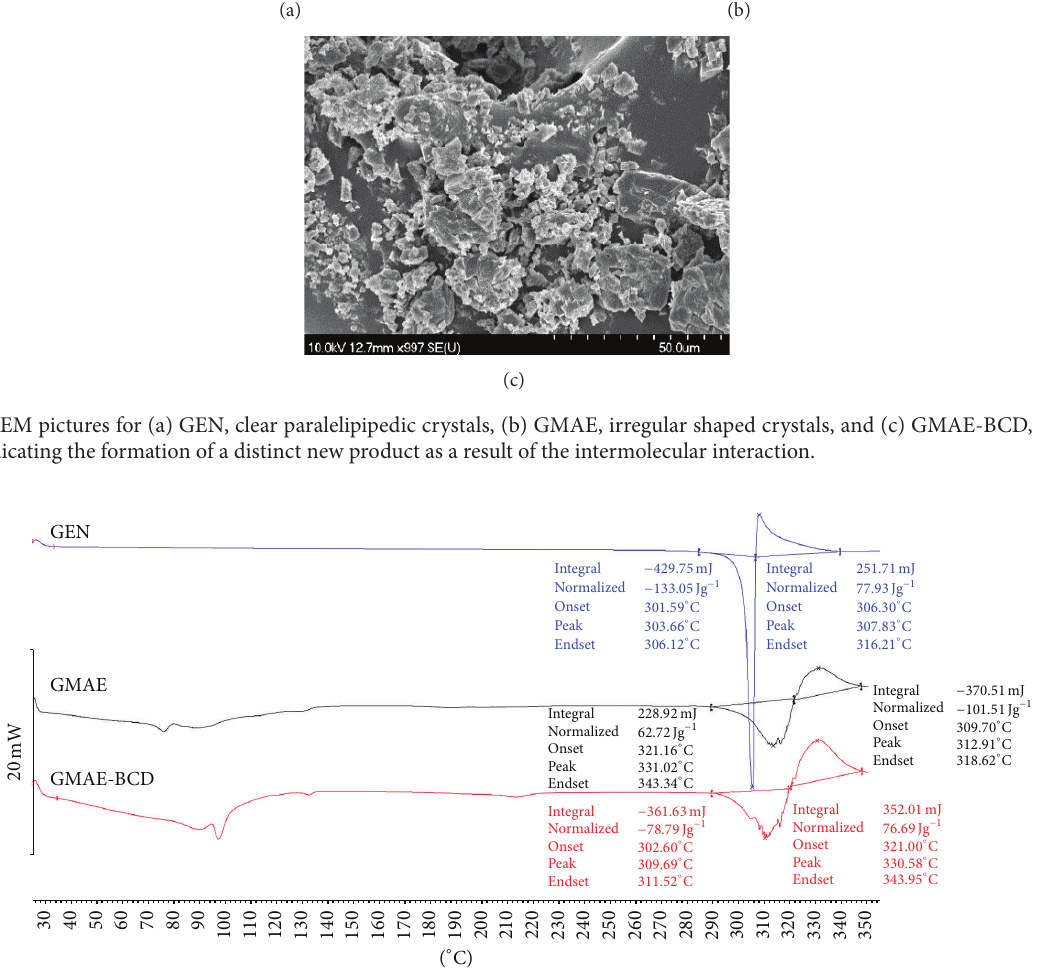
Figure 3: DSC pictures for (a) GEN, sharp endothermic peak around 303 ∘ C abruptly followed by a much smaller exothermic one at 307 ∘ C, indicating a melting of the active compound probably accompanied by a chemical decomposition, (b) GMAE, one endothermic and one exothermicpeak,slightlyshiftedtowardshighertemperatures,313 ∘ Cand331 ∘ C,respectively,and(c)GMAE-BCD,similarprofilewithGMAE. A small water loss can be noticed for both GMAE and GMAE-BCD at around 100 ∘ C, indicating the loss of the “internal” water molecules of the cyclodextrin which were replaced by the guest